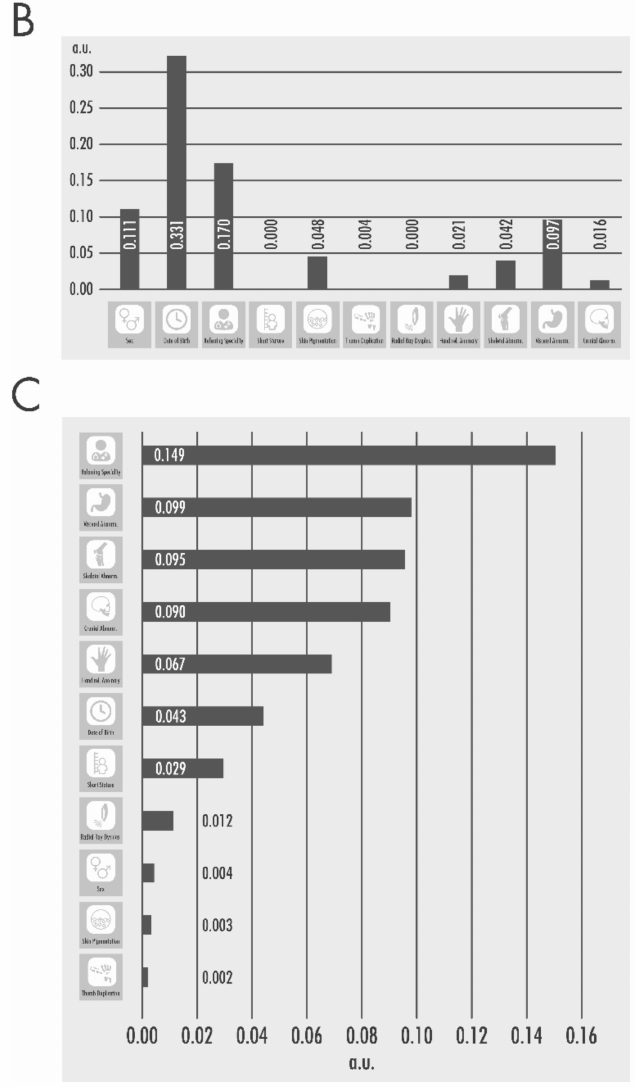
Figure 3. Machine learning approaches used to detect correlations. ( A ) The heat map of the feature correlation matrix unveiled a correlation between hand anomalies, thumb hypoplasia, and radial dysplasia, as well as abnormal pigmentation and cranial abnormality, but no clinical feature was predictive for positive testing of FA. ( B ) CART analysis showed date of birth (score: 0.33), referring specialty (score: 0.17), and cranial abnormality (score: 0.16) as the most important attributes for positive FA testing. ( C ) Attribute evaluation in WEKA with a cut-off at 0.1 showed that no feature predicted a positive FA test